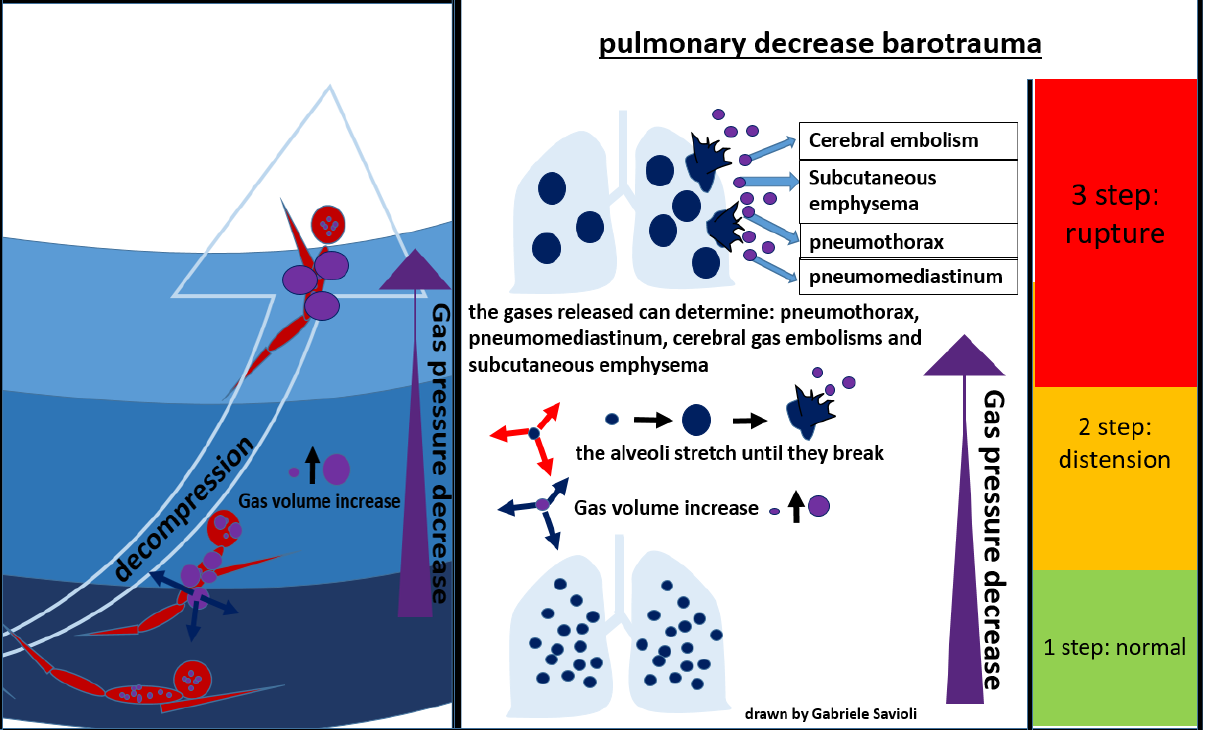
Figure 7. Pulmonary decompression barotrauma.